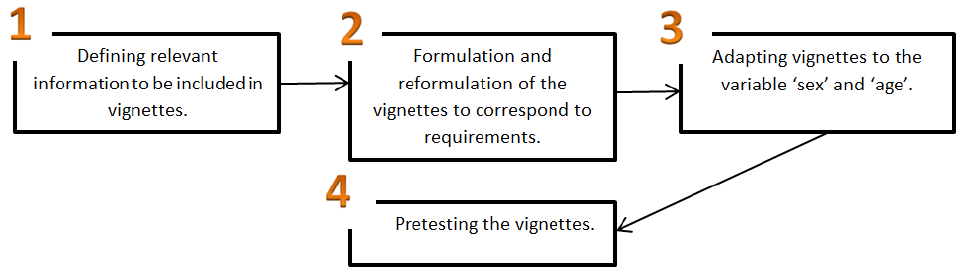
Figure 1. A flow chart indicating the steps for constructing the vignettes. Source: The graphic was created by the authors using Microsoft Word 2010 [57].